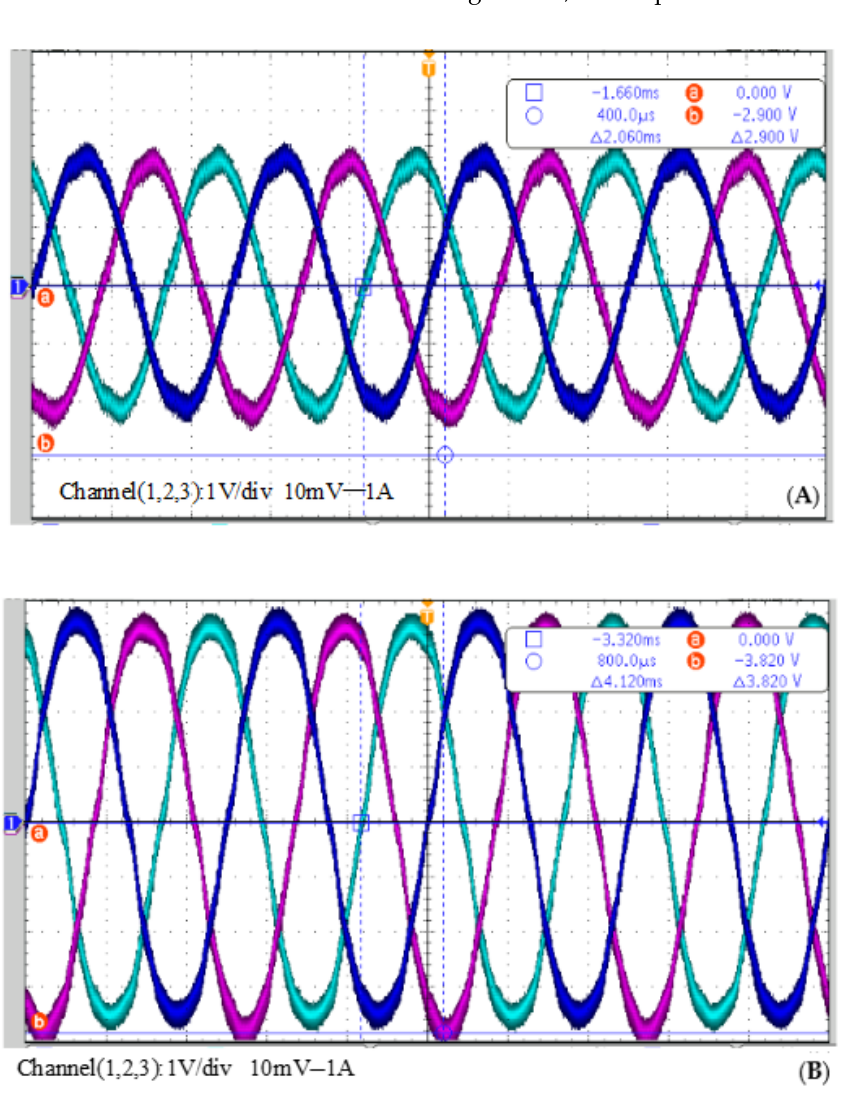
Figure 15. Phase current wave. ( A ) rated load, ( B ) overload. The temperature of the IPMSM parts is measured by thermocouple PTC100 and a FLUKE infrared imaging device. Thermocouple temperature sensors PTC100 are inserted into slotted windings for measuring the temperature of the slotted winding. The outer surface temperature of the IPMSM is measured by using a FLUKE infrared imaging device in Figure 16.